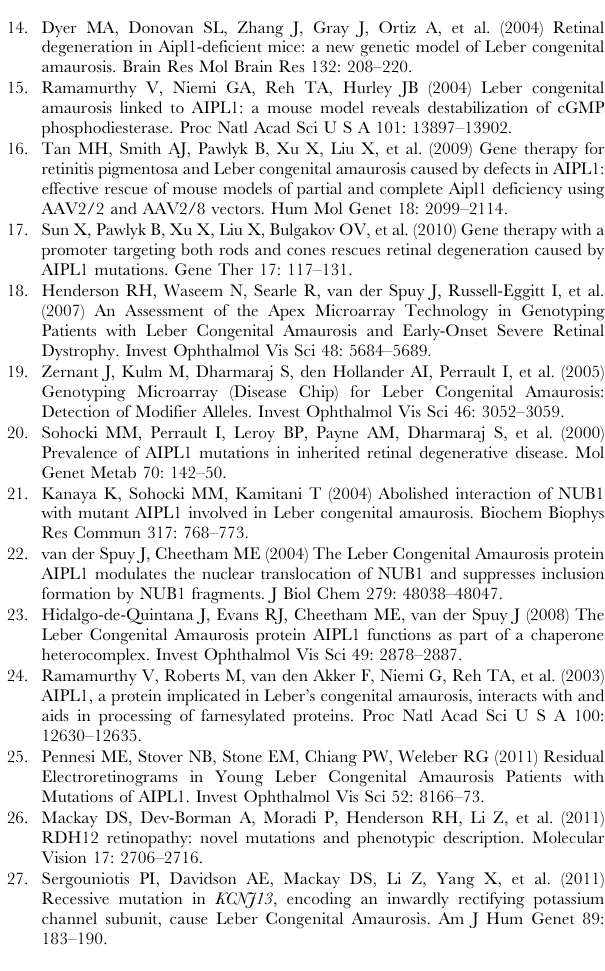
Table S1 Analysis of allelic variants for their effect on splicing. Analysis of 46 variants identified in AIPL1 using the Human splicing finder version 2.4.1 reporting the results from the HSF matrix. The values for the wild type and mutant sequences are showed. The larger the difference between the values the greater that change that the variant can affect the splice